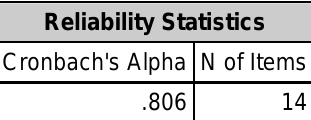
Table 1: Reliability leadership: